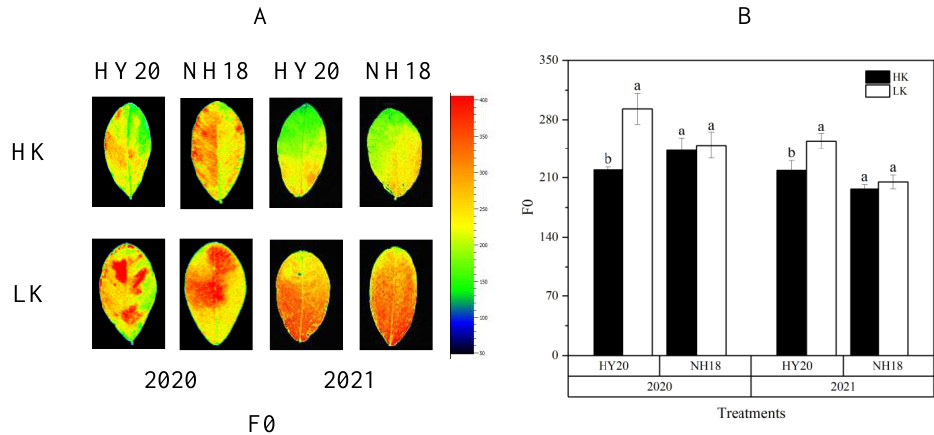
Figure 5. Chlorophyll fluorescence imaging under low K stress. Chlorophyll fluorescence imaging under low K stress-F0 ( A ); Effect of low K stress on fluorescence parameter F0 ( B ). HK: high K treatment; LK: low K treatment. For the bar chart, a,b indicates a significant difference between different treatments for the same variety ( p < 0.05).